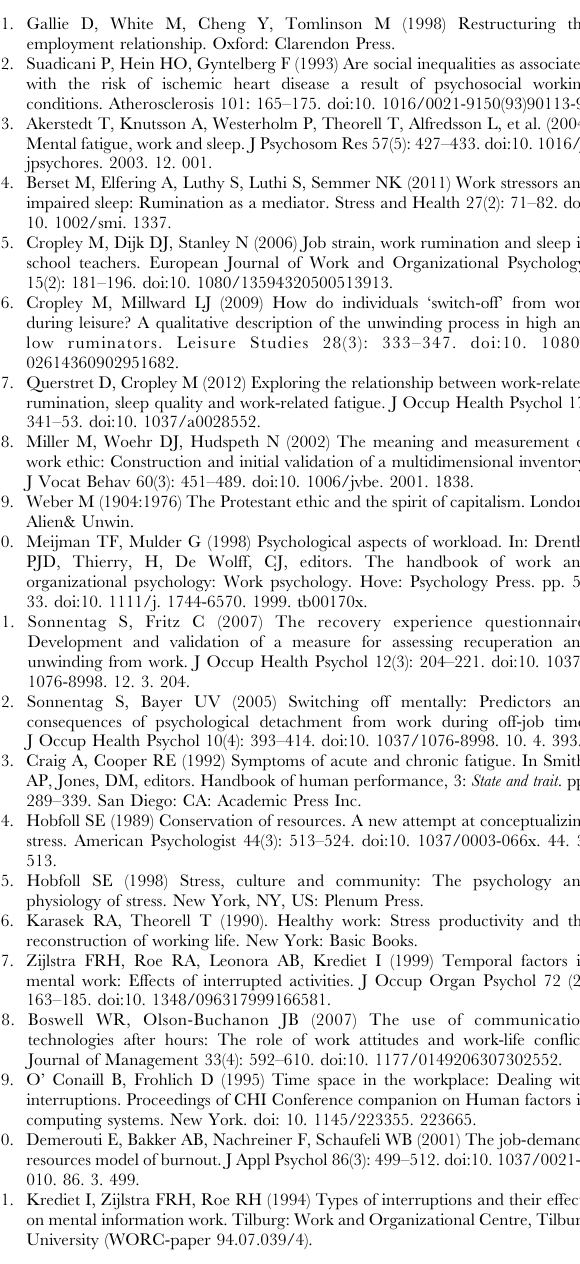
Table S2 Significant regression analyses for direct and indirect effects of positive and negative interruption on problem-solving pondering via anti-leisure and wasted time beliefs. Table S3 Results of regression analysis of negative interruption and work beliefs on three types of work rumination. Table S4 Results of regression analysis of negative interruption and work beliefs on three types of work rumination.